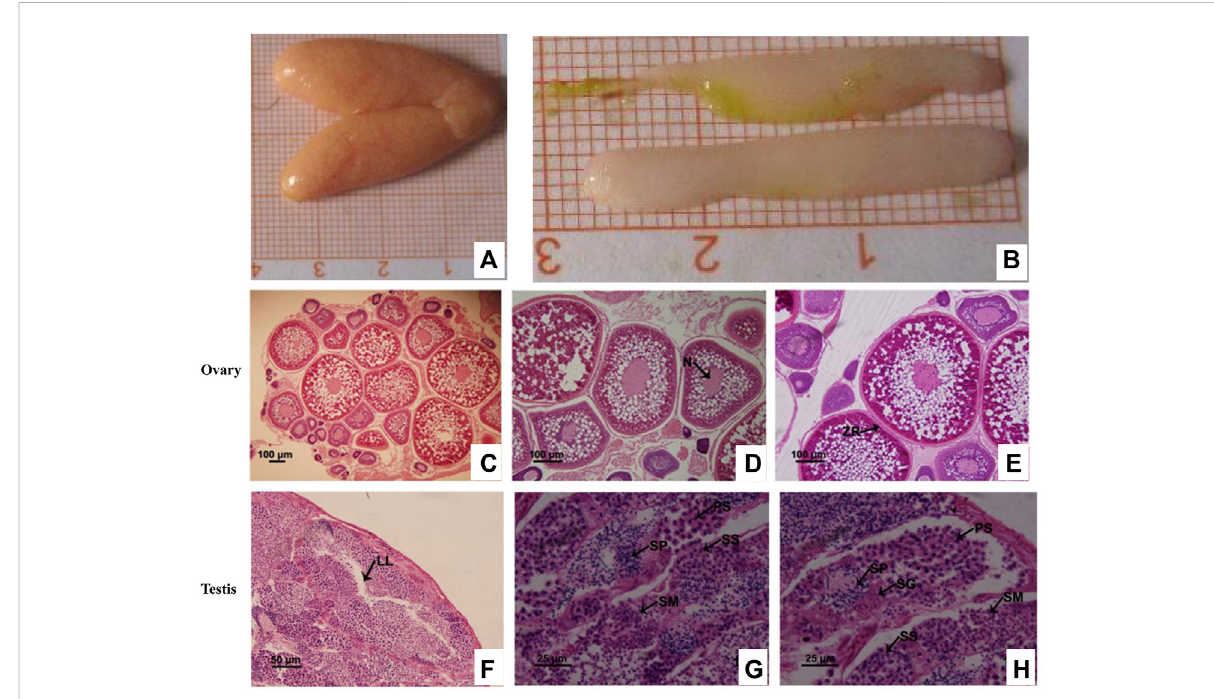
FIGURE 1 Histological characteristics show the speci fi c periods of cells in the ovaries and testes from sexually mature Collichthys lucidus . (A) The morphology of the ovaries. (B) The morphology of the testes. (C) Hematoxylin and eosin (HE) staining of the ovary at stage IV. (D) Early oocytes in phase IV. Arrow shows the deformed nuclei (N). (E) Metaphase oocytes in phase IV. Arrow shows the zona radiate (ZR). (F) HE staining of the testis at stage IV. Arrow shows the lobular lumen (LL). (G,H) Germ cells in the testis at stage IV. PS: primary spermatocyte; SG: spermatogonia; SM: spermatid; SP: spermatozoa; SS: secondary spermatocyte. Note: Figure 1D and Figure 1E are speci fi c periods of oocytes in stage IV ovary. Figure 1G and Figure 1H are speci fi cperiods of germ cells in stage IV testis. Different imagesshow differentcells at aspeci fi cperiod, and the images are from a fi eld of the same sample, so there is overlap view between the images to illustrate different